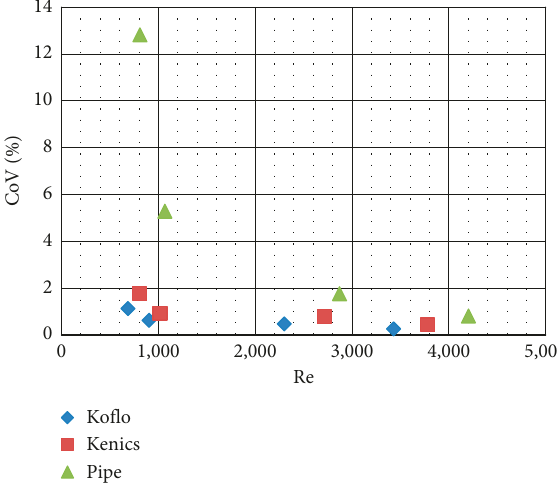
Figure 2: CoV versus Re number for considered devices